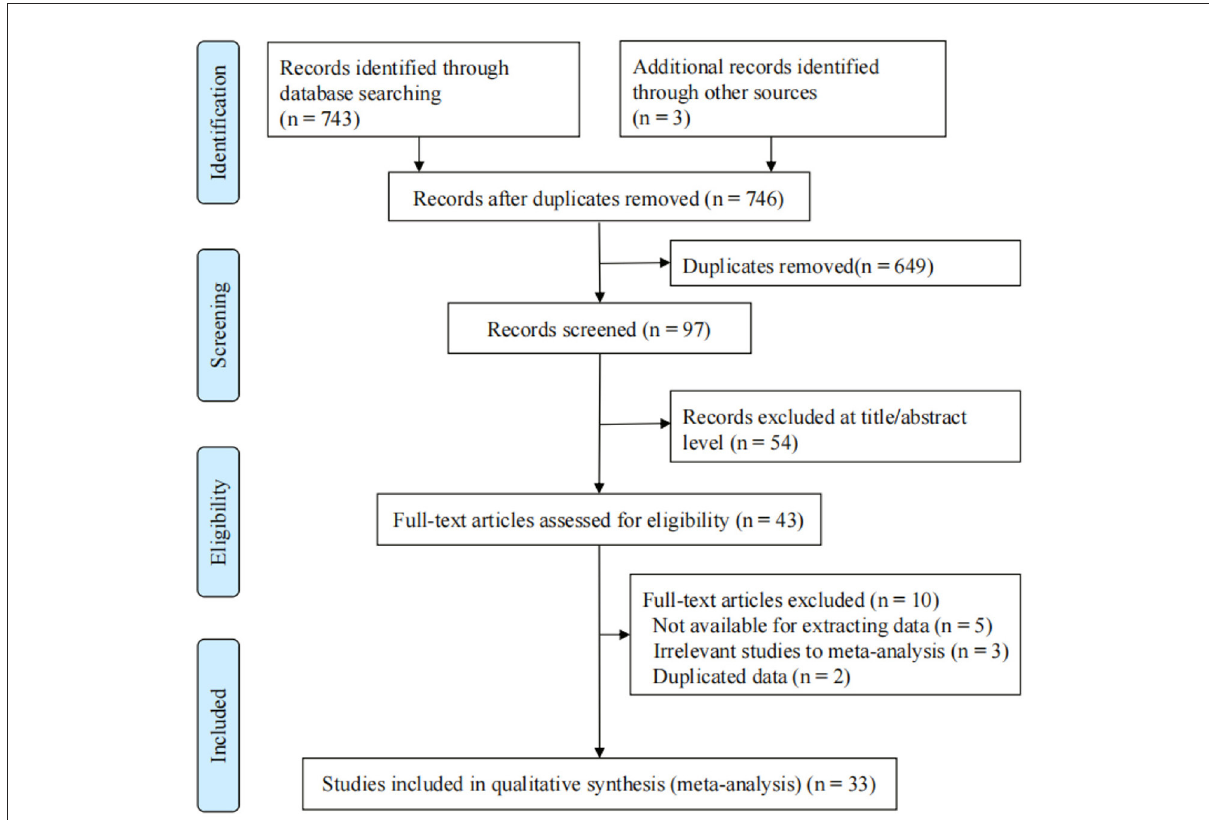
FIGURE1 PRISMA 2009 Flow